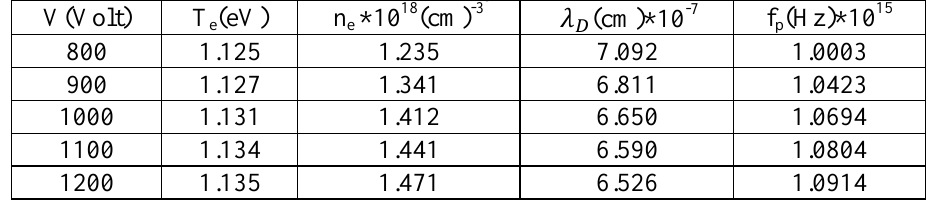
Table 4: Plasma parameters ( , , and f